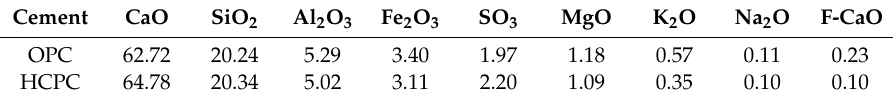
Table 1. Chemical compositions of the two di ff erent cement specimens (wt.%).